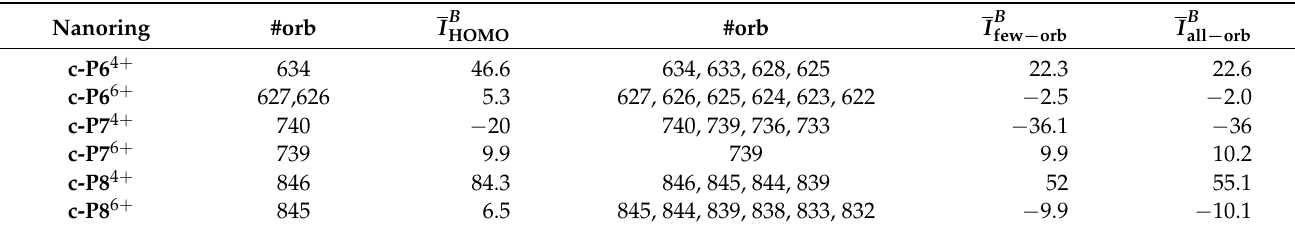
Table 4. Signed current strengths in nA T − 1 for the middle C-C bond of a butadiene bridge (Figure 3) and their approxima- tions in terms of the sum of the few orbitals close to the Fermi level. The degenerate orbitals 627 and 626 are HOMO − 6 and HOMO − 7 in c-P6 6 +